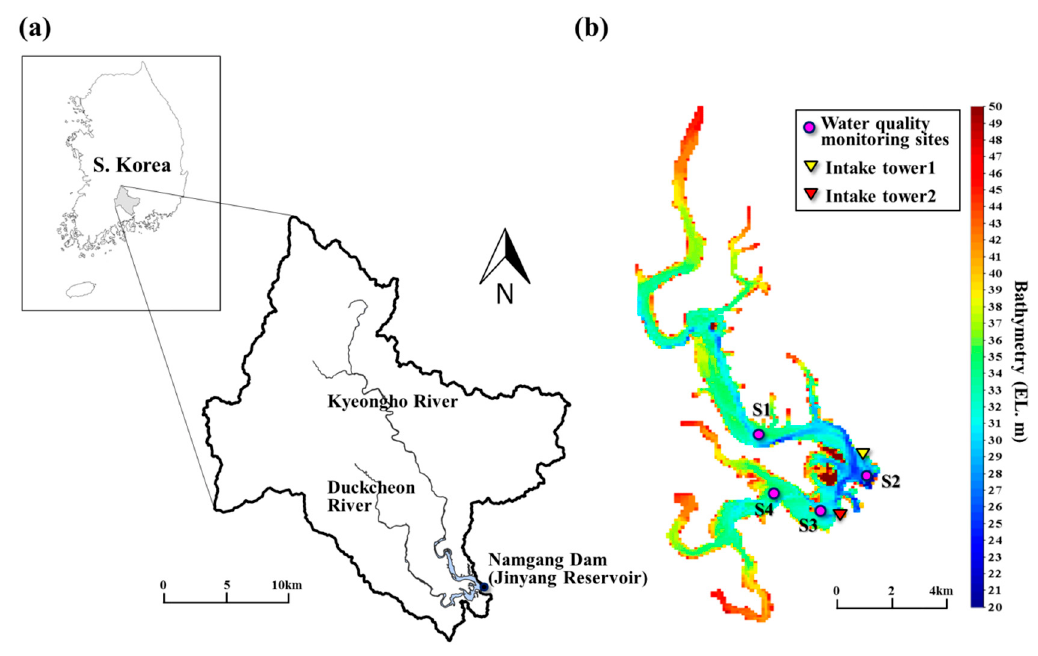
Figure 1. ( a ) Location of the Namgang Dam (Jinyang Reservoir); ( b ) Bathymetric map of the Jinyang Reservoir including the location of water quality monitoring sites and intake towers. The scale of the color bar scale is in units of elevation meter (EL. m).